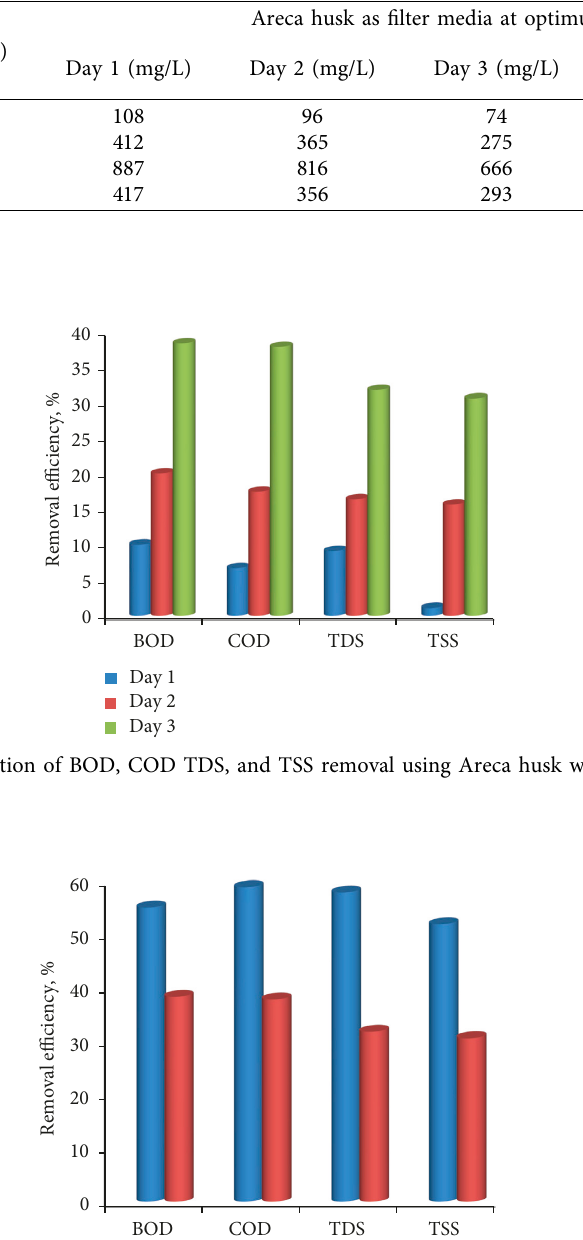
Table 3: The removal efficiency of wastewater using Areca husk as filter media.